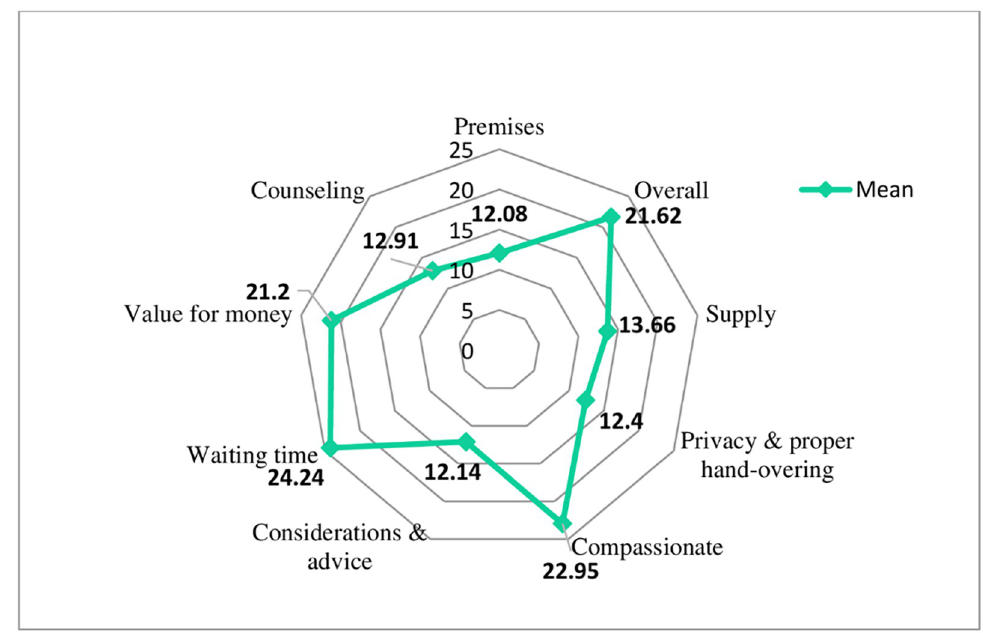
Fig 3. Radar chart, indicating the mean variation for dimensions of client satisfaction, December 2020.